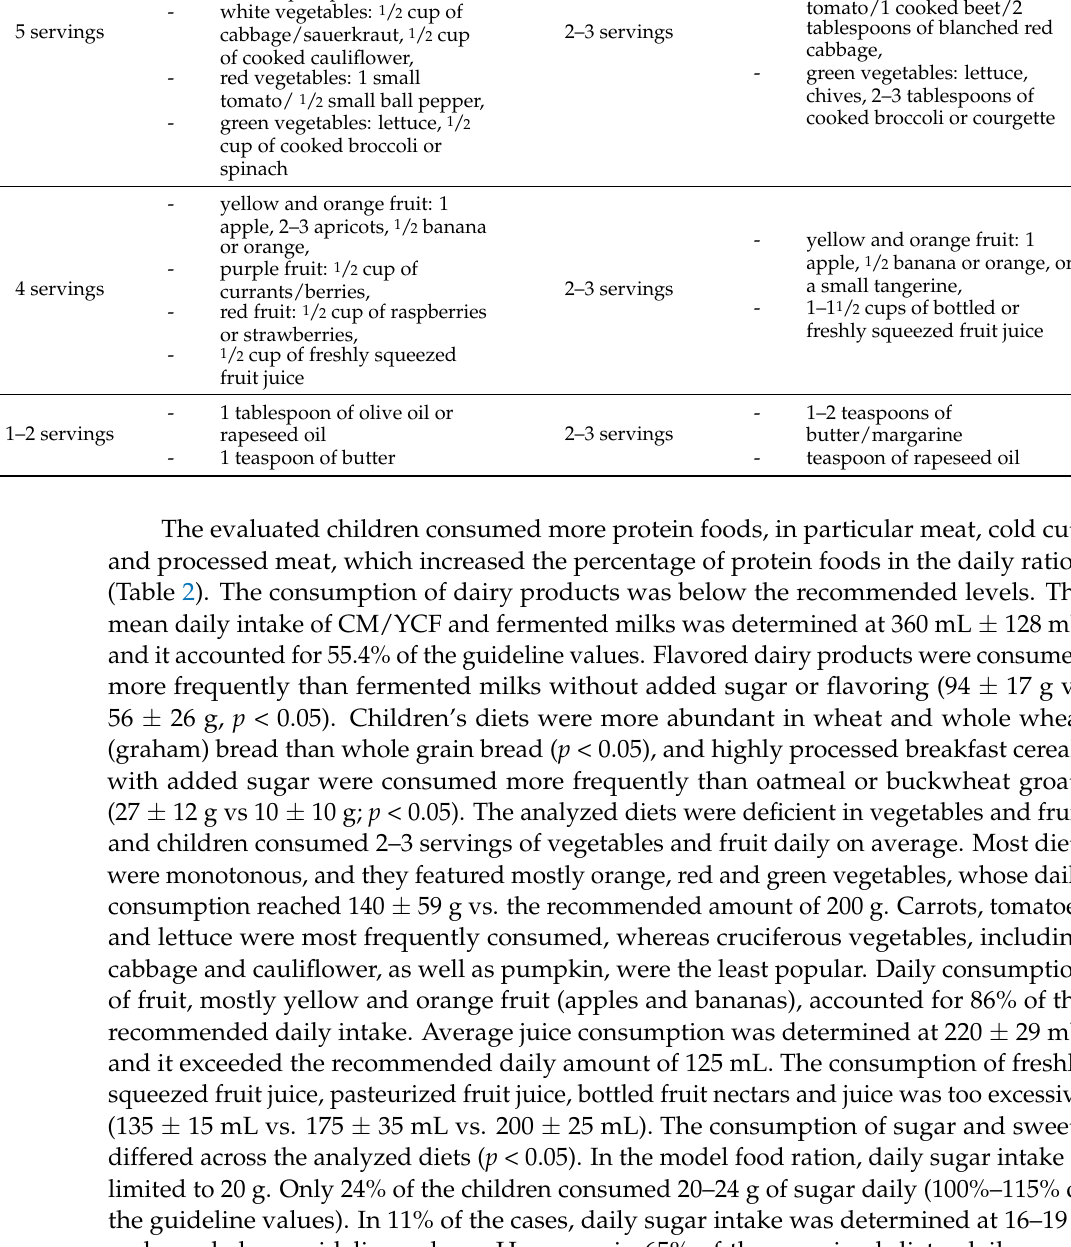
tablespoons of blanched red